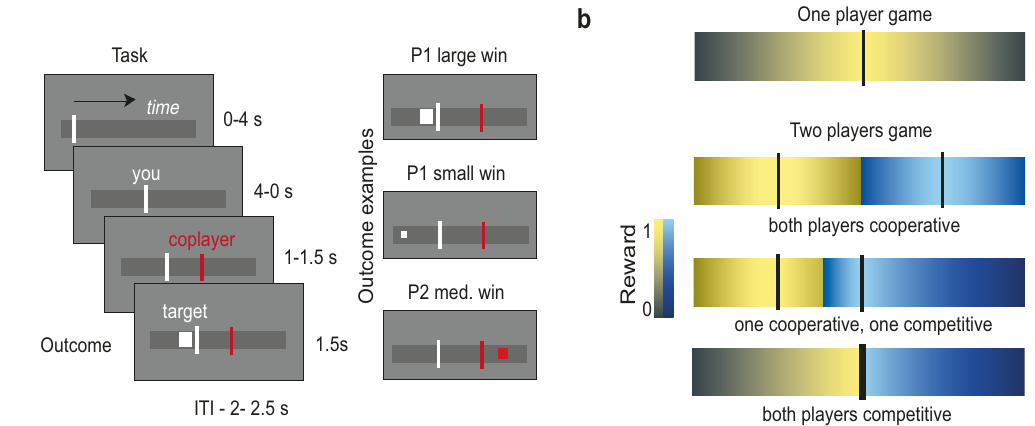
Fig. 1 | Schematic representation of the Space Dilemma. a Participants fi rst positioned themselves in the space, hidden from the other player. They were then presented with a bar moving across the space (representing their location) and were required to commit to a certain location by pressing a button while the bar was moving through it. The bar would take 4 s to reach the end of the space. Once they responded, the bar stopped at the chosen location and was shown for the remainder of the 4s. After both counterparts positioned themselves, their respective positions were shown to each other for 1 – 1.5 s before the target appeared (leftpanel). The player closer to the target won the trial (three examples in right panel) as identi fi ed by the colour of the target. The reward obtained is inverselyproportionaltothe distanceto thetarget, and re fl ectedbythe sizeofthe targetsquare. b Theaveragerewardforeachplayerdependsonthe positioninthe